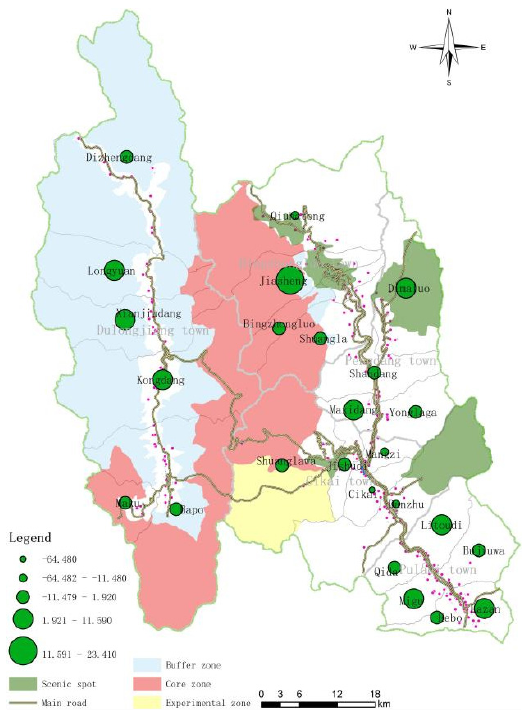
Figure 4. The change in residential land in the study area.